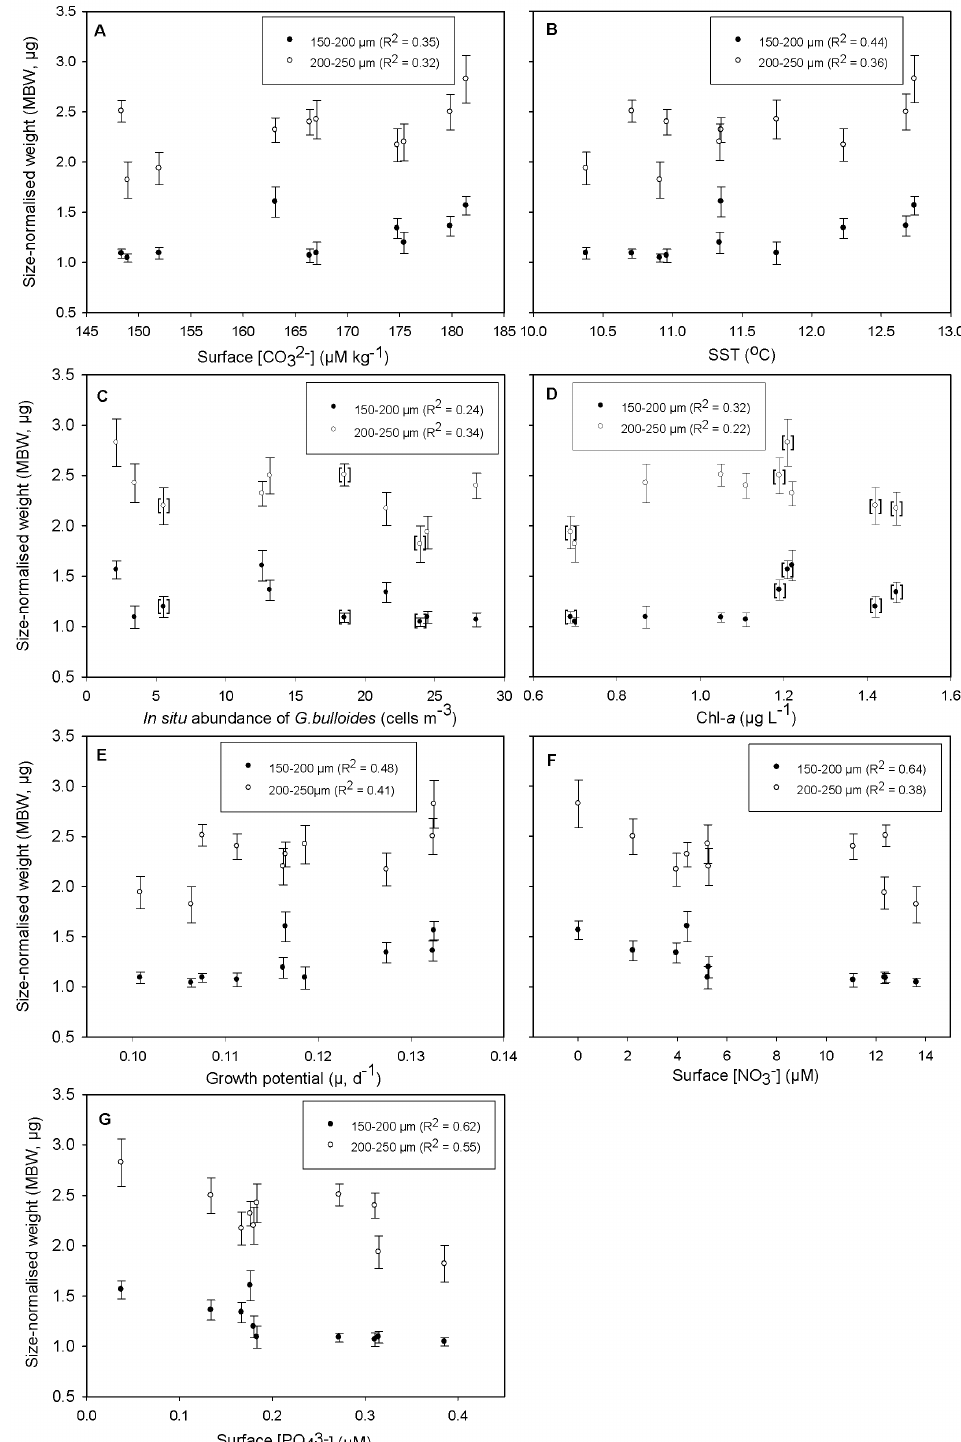
Fig. 3. SNWs of G. bulloides for 150–200µg (filled symbols) and 200–250µg (hollow symbols) size fractions compared to: (A) [CO 2 − (B) sea surface temperature, (C) in situ abundance of G. bulloides (brackets around symbols denote values where a correction factor was applied), (D) chlorophyll a (brackets around symbols denote where calibrated underway values have been used), (E) growth potential, (F) [NO − ] and (G) [PO 3 − ]. Error bars represent the reciprocal of the number of specimens weighed per aliquot multiplied by mean specimen 3 4